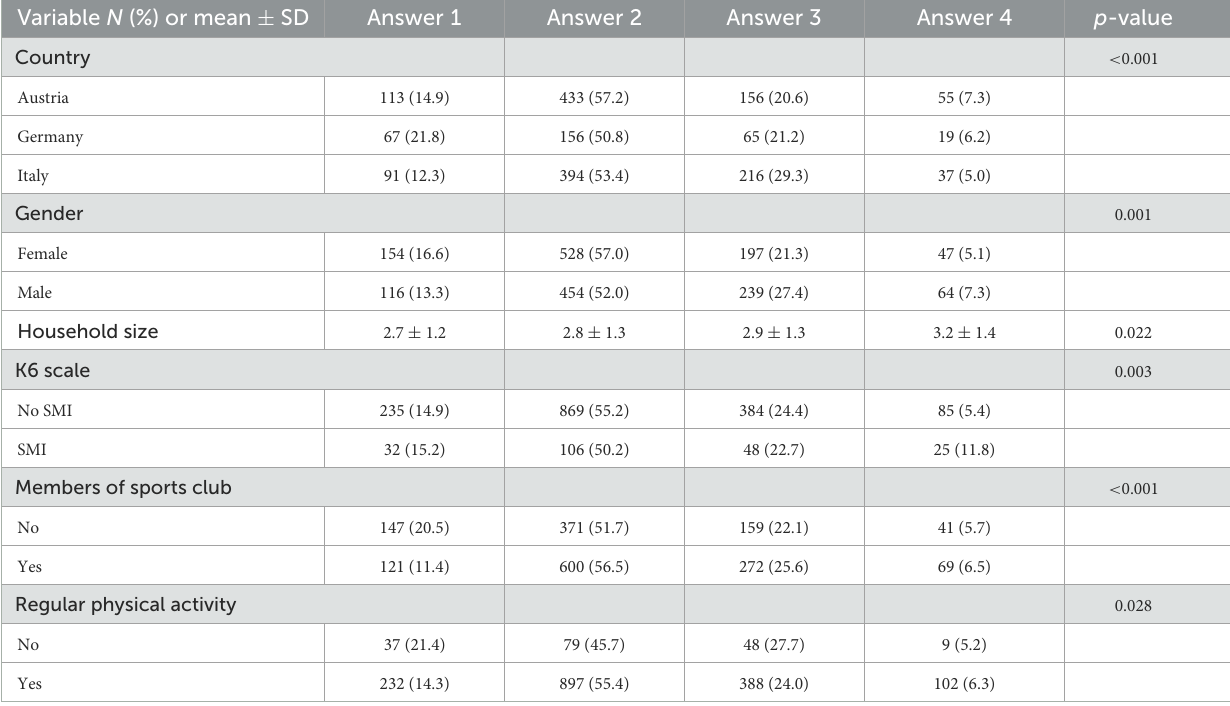
TABLE 2 Handling of major sports events in the Alpine regions of Austria, Germany and Italy. Variable N (%) or mean ±